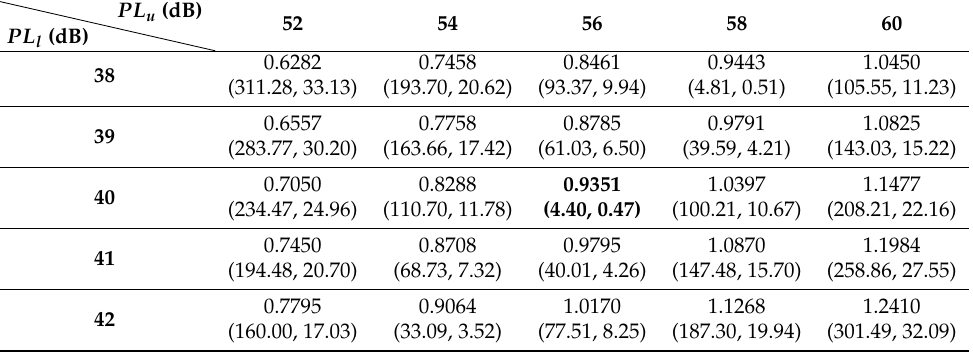
Table 2. Estimation of the step length (m), absolute estimation error (mm), and relative error (%) in the indoor jogging scenario for different pairs of upper threshold PL u (dB) and lower threshold PL l (dB).